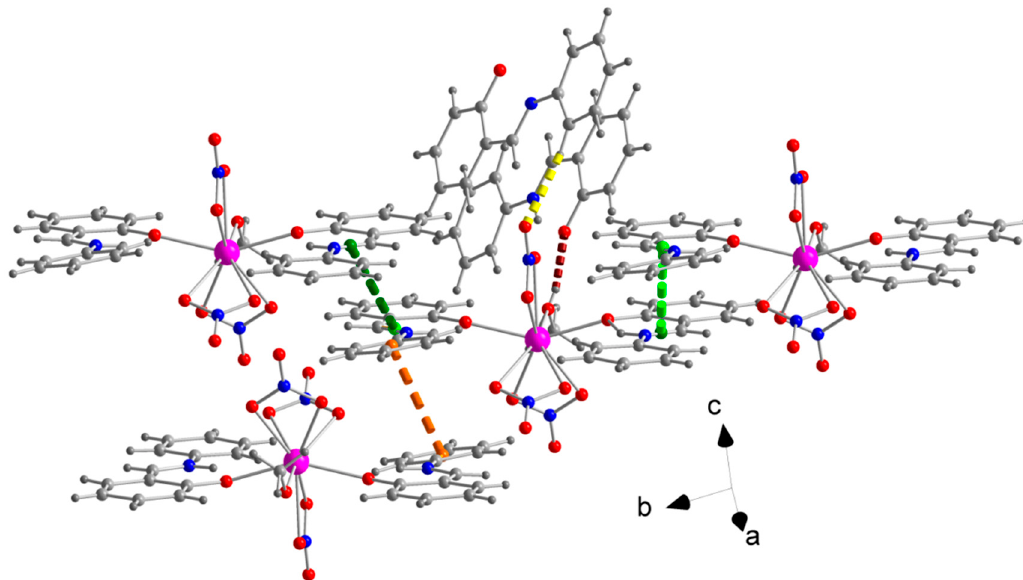
Figure 8. Different types of intermolecular interactions in the crystal structure of 18 _Dy. The dashed dark green and light green lines indicate the two types of π - π interactions between coordinated salanH ligands. The dashed orange lines indicate π - π stacking interactions between centrosymmetrically-related aniline rings of coordinated salanH ligands. The dashed yellow and dark red lines represent the C36-H(C36)···O11 and O12-H(O12)···O13 ( − x , − y + 2, − z + 2) H bonds, respectively, which link the [Dy(NO 3 ) 3 (salanH) 2 (MeOH)] complex molecules and the lattice (i.e., non-coordinated) salanH molecules. Atom C36 is an aromatic carbon atom that belongs to the aniline ring of the lattice salanH molecule.